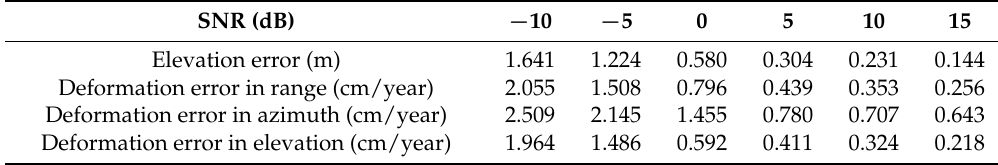
( e ) Figure 9. Results of the estimations: ( a ) SAR simulated image generated by Giorgio Franceschetti’s method. ( b ) is the estimation result of elevation. ( c ), ( d ), and ( e ) are the estimations of deformation velocity in the direction of slant range, azimuth, and elevation.